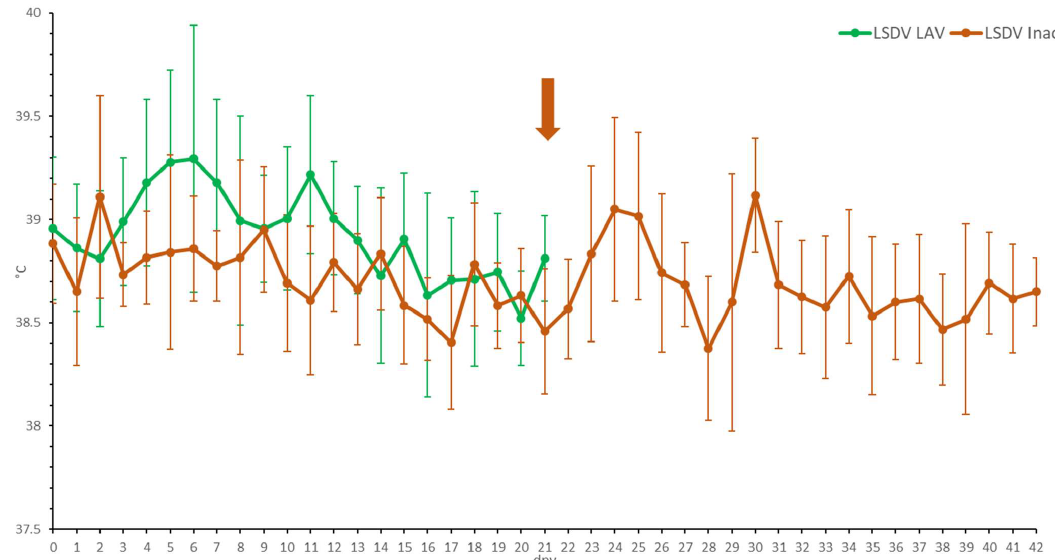
Figure 1. Averaged body temperatures of the LSDV LAV and the LSDV Inac animals after vaccination. Solid line: fever cut-off for consecutive days; arrow: moment of booster vaccination for LSDV Inac; standard deviation is shown as error bars.